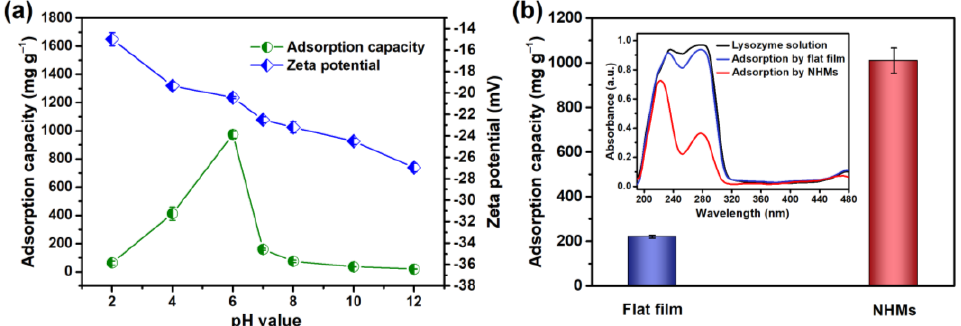
Figure 7. ( a ) Adsorption performance and Zeta potential of the NHMs at various pH values. ( b ) Performance comparison of the NHMs and functional hydrogel flat film; insert exhibits the UV spectra of the lysozyme solution before and after